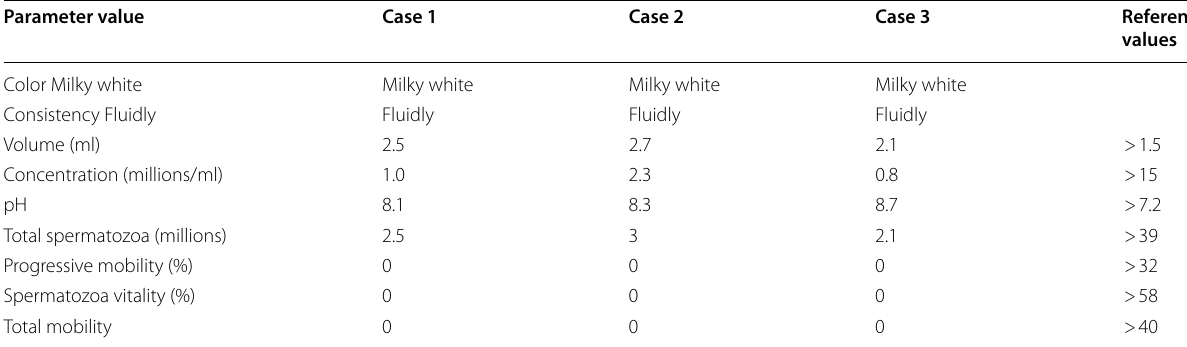
ectopic ureter and seminal vesicle as a convoluted tail communicating with the cystic lesion and seminal vesical, which quite often is lost at other radiological modalities.